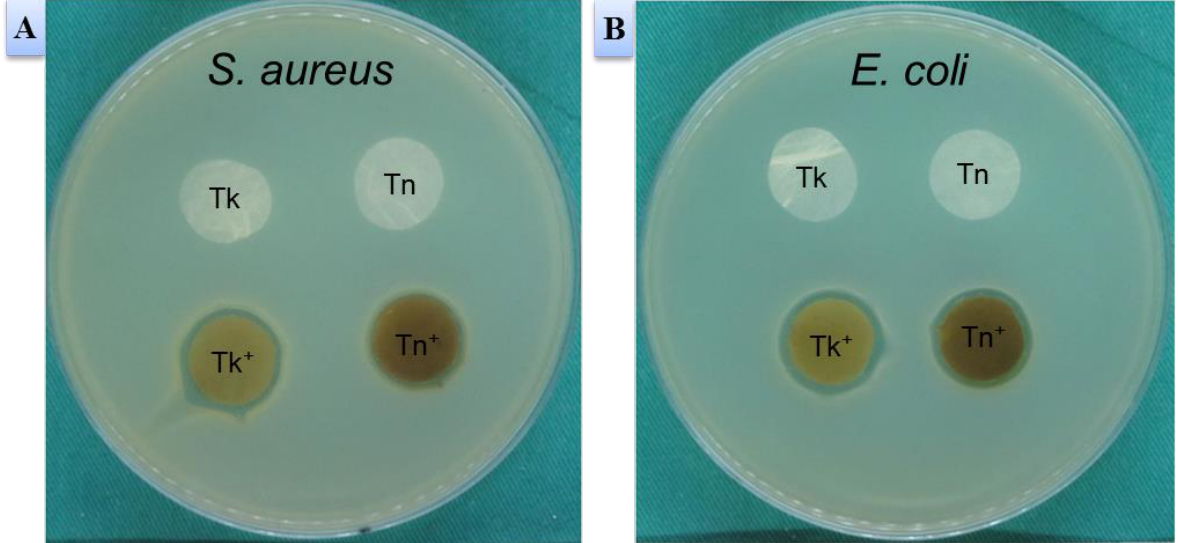
Figure 6. The antibacterial activity of CSNFMs determined from the bacteriostatic rings for S. aureus ( A ) and E. coli ( B ). A disk shaped membrane with 1.5 cm diameter is used in the study and the weight of Ag NPs in Tn + and TK + are ~0.0195 and ~0.0325 mg, respectively.